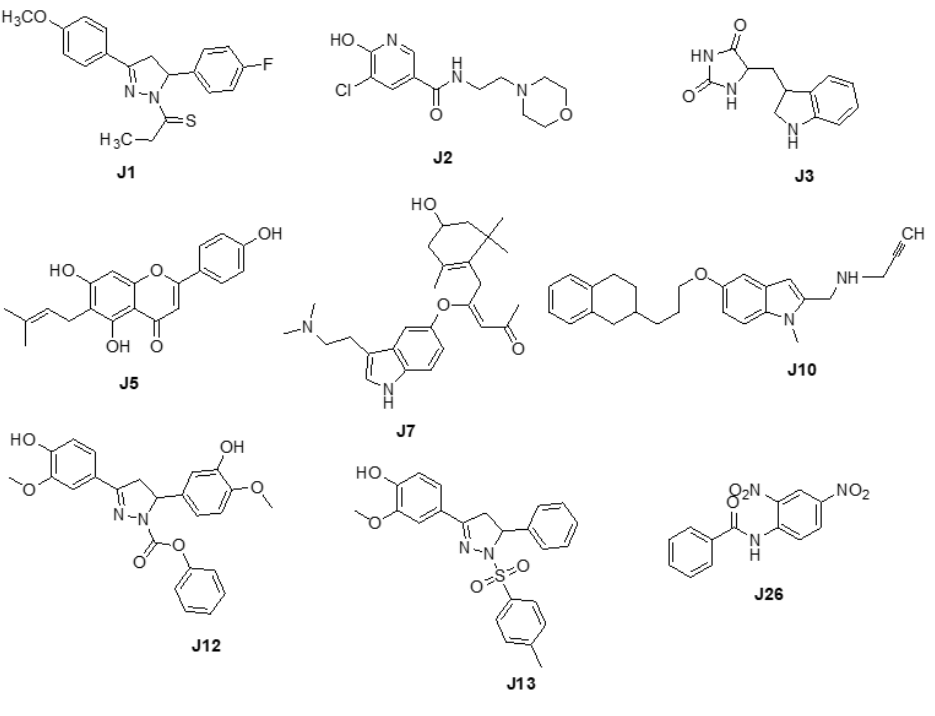
Figure 1. Chemical structures of J1 - J3 , J5 , J7 , J10 , J12 , J13 , and J26 .